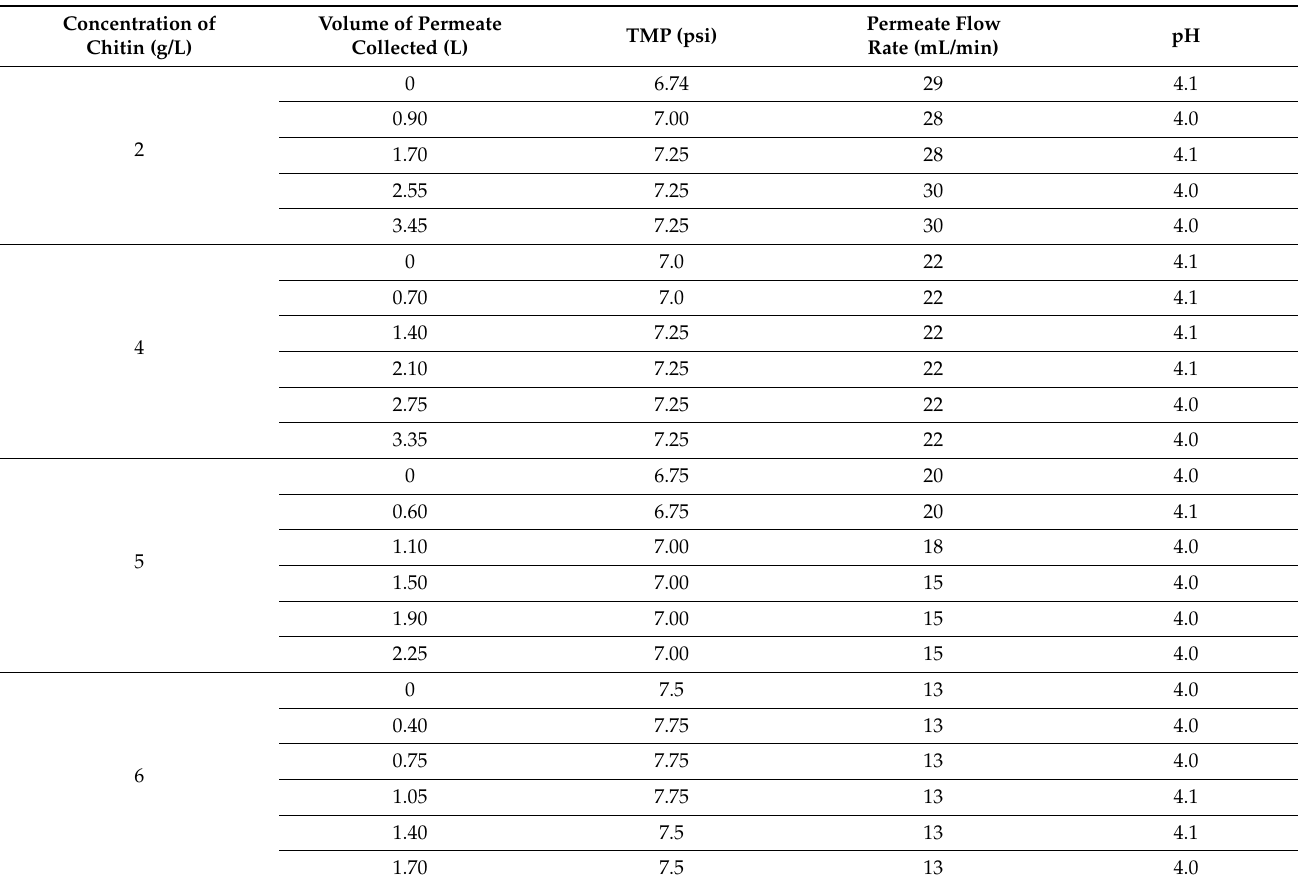
Table 2. CEFP with 20 mg/L Cobalt and various chitin concentrations effects on trans-membrane pressure (TMP), permeate flow rate, and